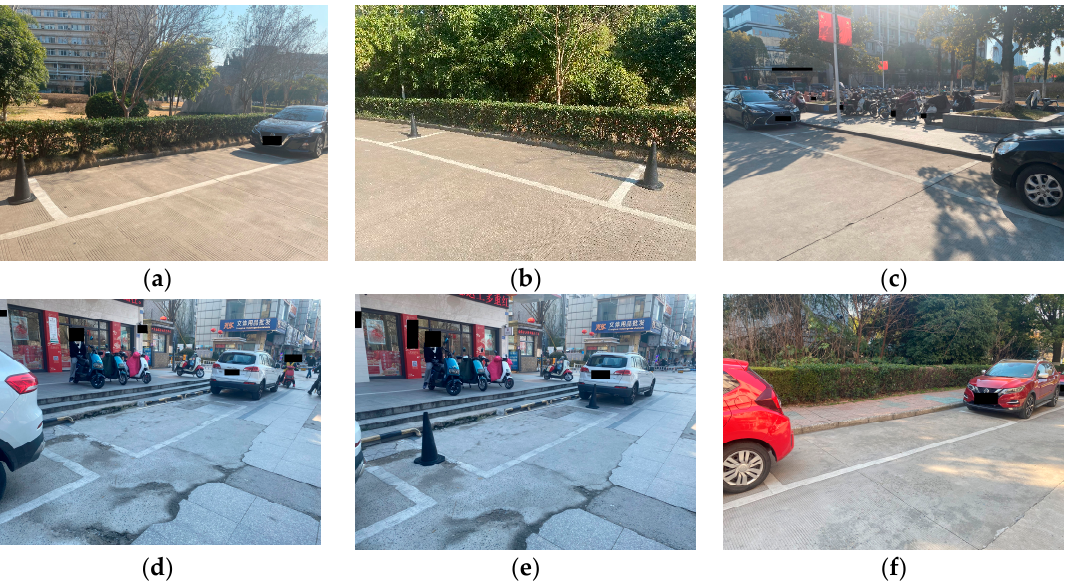
Figure 15. Actual parallel parking slot: ( a ) Vehicle obstacle, columnar obstacle, and curbstone obstacles; ( b ) columnar obstacle and curbstone obstacles; ( c ) vehicle obstacle and curbstone obstacles; ( d ) vehicle obstacle and fuzzy parking slot line; ( e ) vehicle obstacle and columnar obstacle and fuzzy parking slot line; and ( f ) vehicle obstacle and covered parking slot